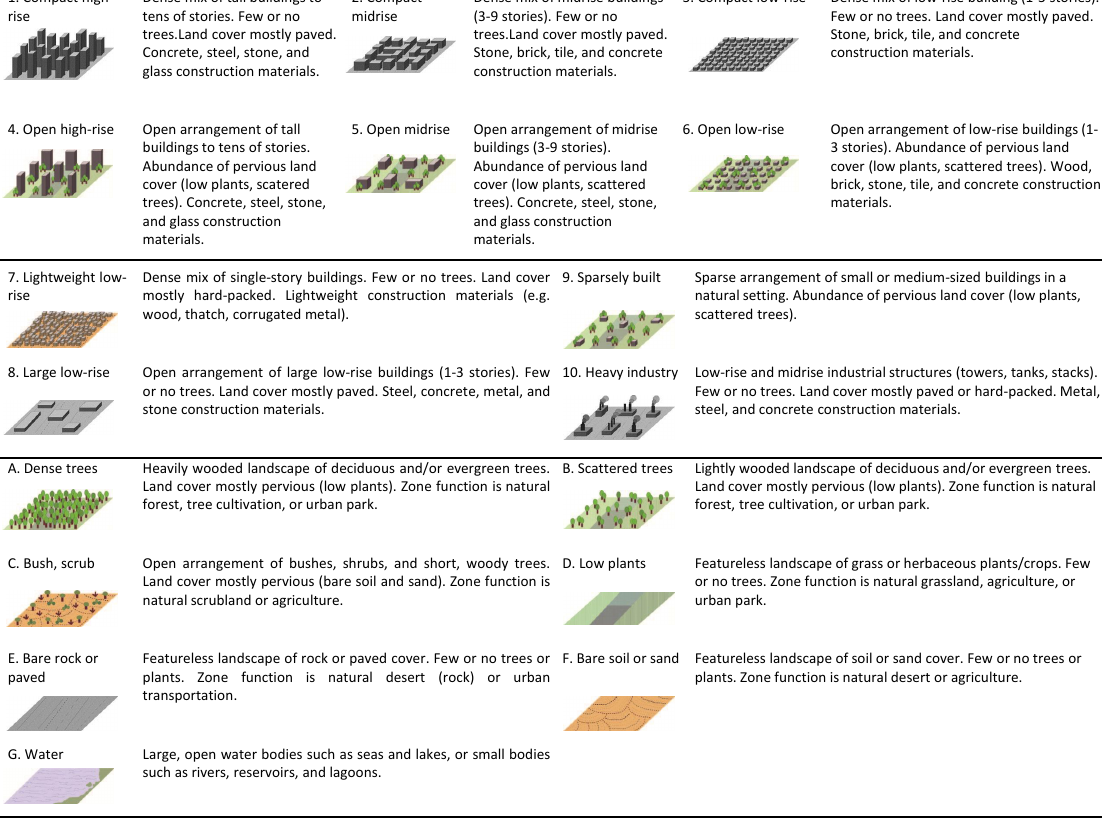
Figure 1. Description of LCZ classes. (adapted from